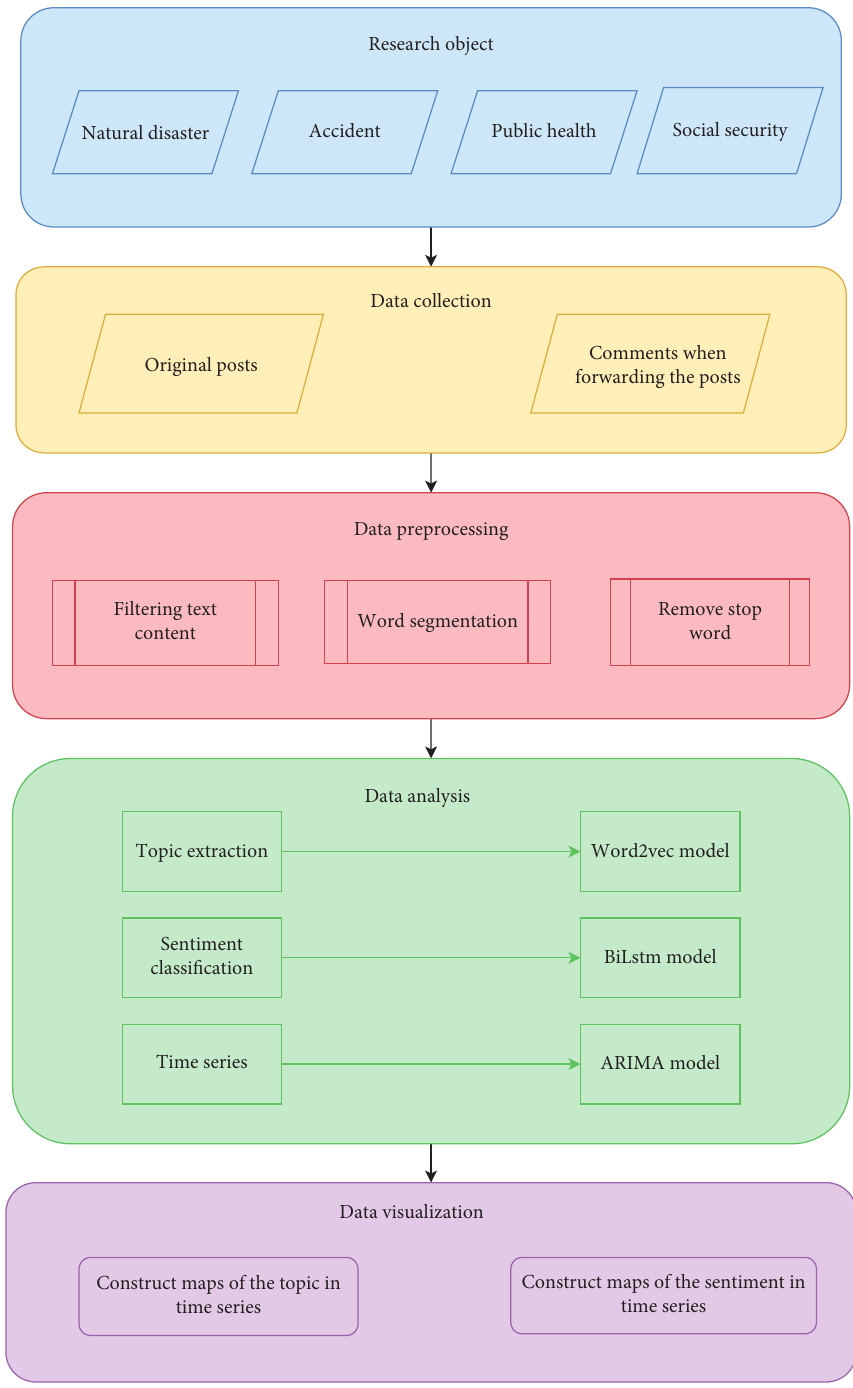
Figure 3: Research